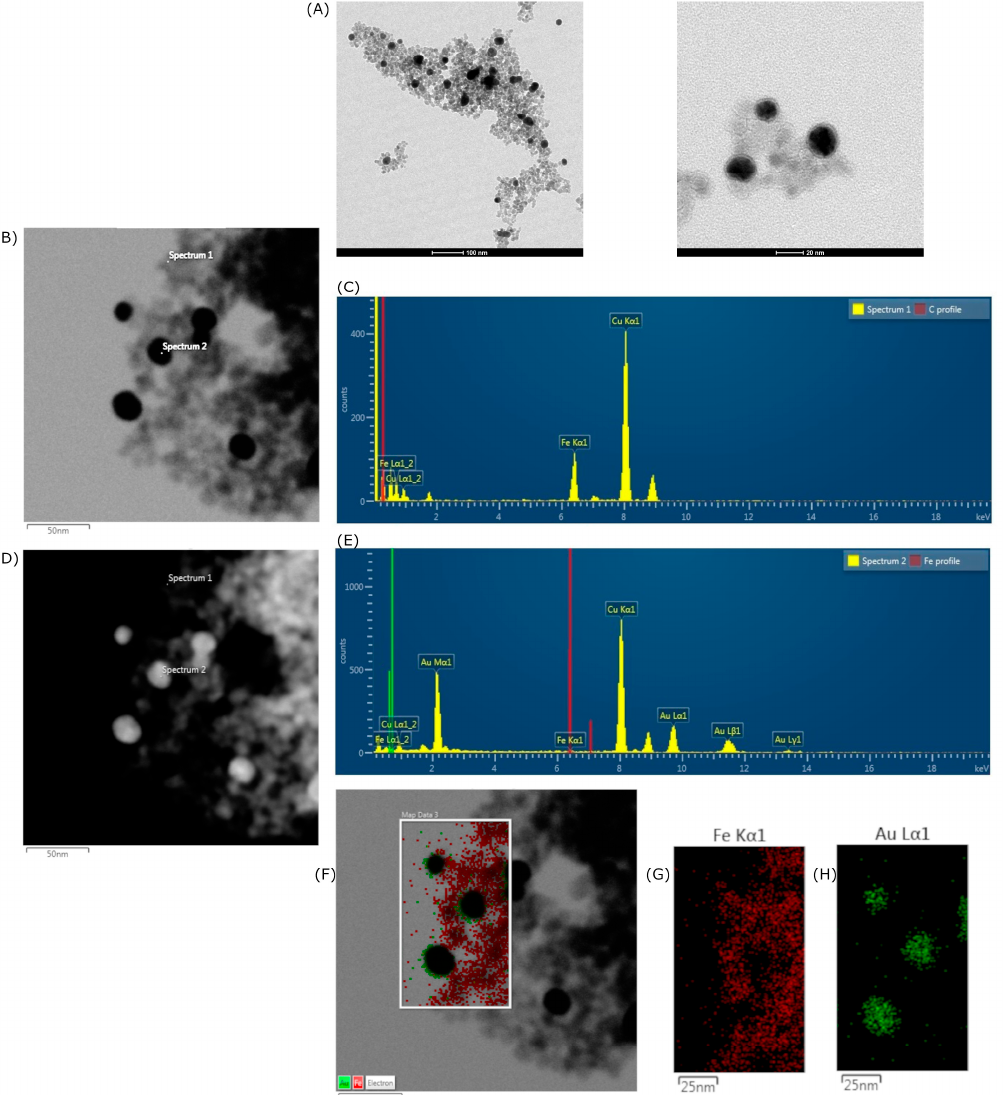
Figure 3. TEM and EDS analysis of SPIONs@Au: ( A ) SPIONs@Au; ( B ) bright-field micrograph; ( C ) EDS spectrum marker “Spectrum 1”; ( D ) dark-field micrograph; ( E ) EDS spectrum marker “Spectrum 2”; ( F ) micrograph with EDS map of Fe and Au distribution in the rectangle selected in the image; ( G ) Fe; ( H ) Au.